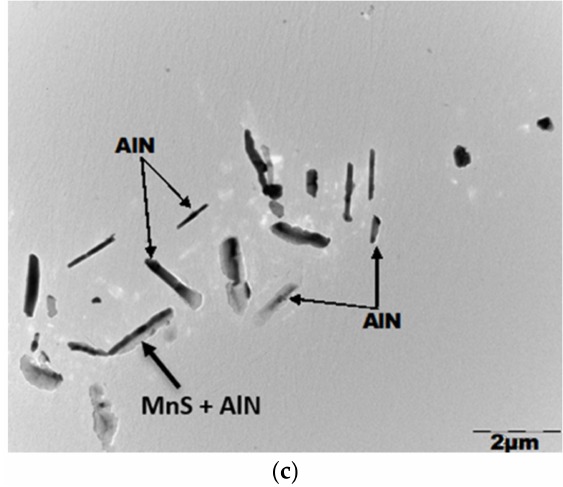
Figure 11. Various forms of AlN precipitation at the boundaries in as-cast high Al, TWIP steels (0.6% C, 18% Mn). Thin films of AlN on the dendritic surface of a high Al, TWIP steel ( a ) 1.6% Al, 0.007% N, ( b ) 1.4% Al, 0.004% N and very low S, 0.002% S ( c ) Very coarse AlN precipitates situated at the austenite grain boundaries [26,27].